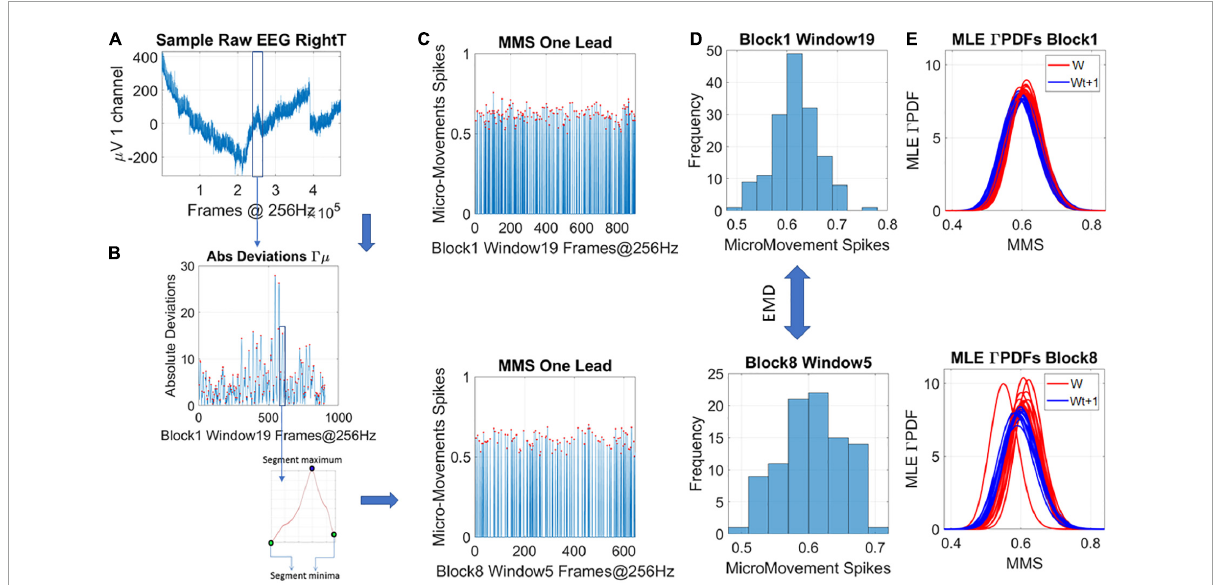
FIGURE2 Transforming continuous analog signals to digital spikes: micro-movement spikes MMS. (A) Sample electroencephalographic signal from one hub channel determined through network connectivity analyses, zooming into one segment. Sweeping through the signal, windows of 5 s with 50% overlap are taken to scale each peak value deviated from the empirically estimated mean ( µ V). (B) For each participant, the original peaks are used to empirically estimate the mean amplitude across the session, and obtain, for each point in the time series, the absolute deviation from the mean. This series of fluctuations are then used to scale out possible allometric effects from e.g., anatomical head differences, using equation 1 in the methods. (C) The unitless, standardized MMS are plotted as time series conserving the original peaks’ timing, shown here for two sample states in some window of blocks 1 and 8. (D) The peaks (red dots) are gathered into a frequency histogram to obtain the histogram’s difference, from window to window (block by block), using the earth movers’ distance, a similarity metric used in transport problems. We then obtain the amount of effort that it takes to transform one frequency histogram into the other. (E) Using maximum likelihood estimation (MLE) the best continuous family of probability distributions fitting the frequency histogram is obtained, shown here for different time